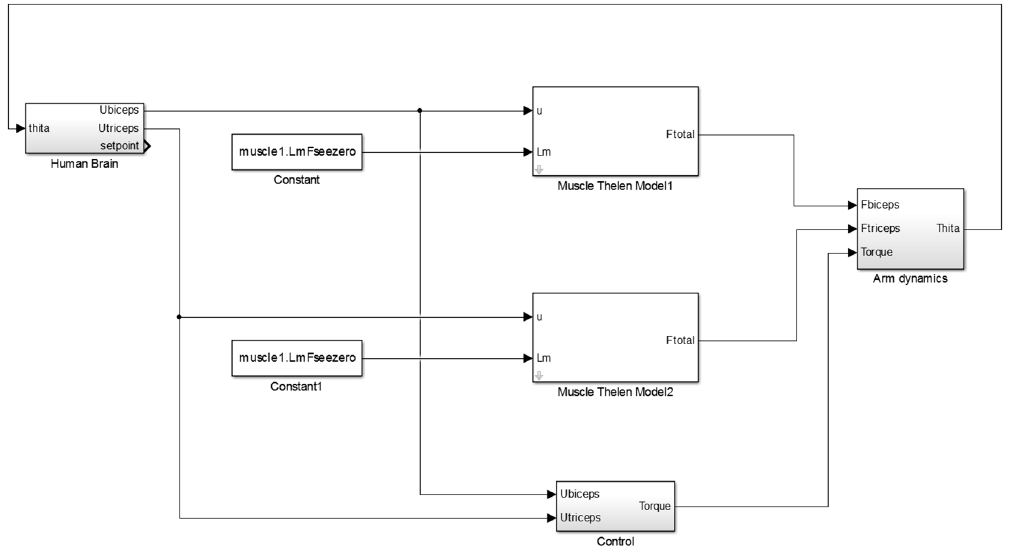
Figure A.1. General Simulink diagram used in the orthosis control.